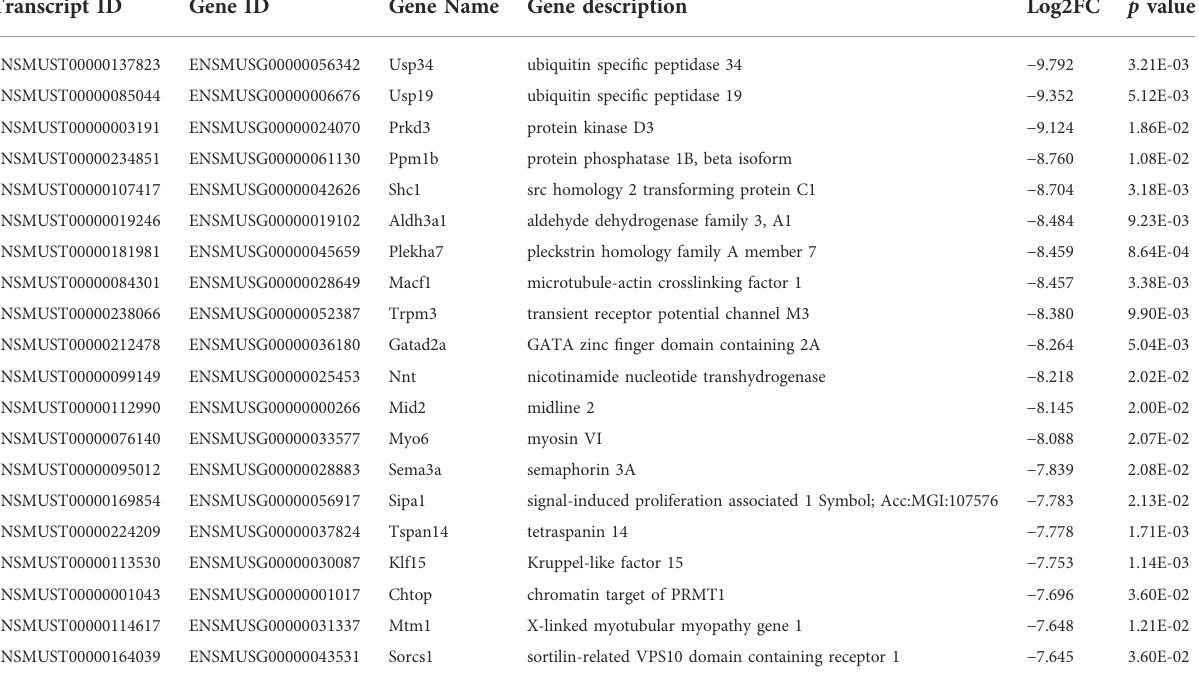
TABLE 4 Top 20 downregulated mRNA ( p < 0.05) between FDM and fellow